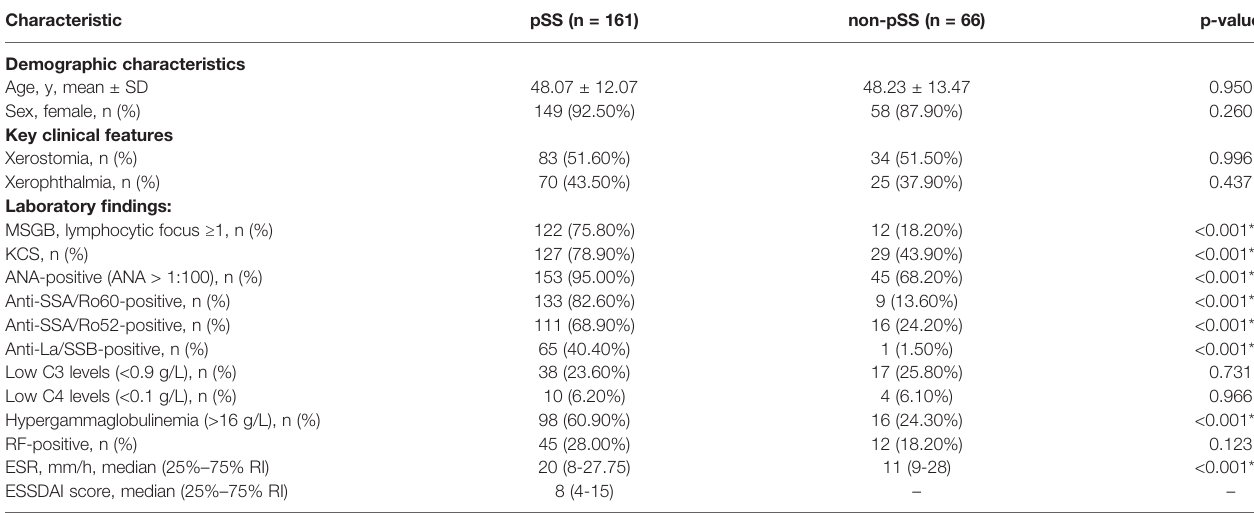
TABLE 1 | Demographic and clinical characteristics of pSS and non-pSS